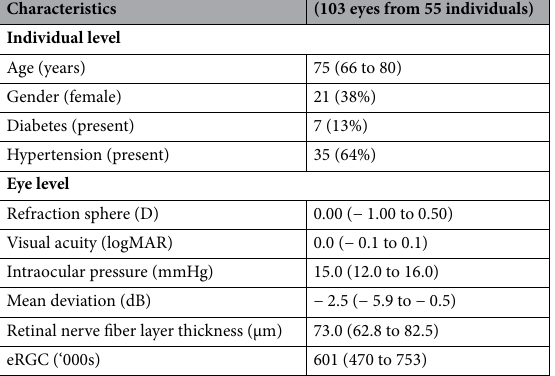
Table 1. Characteristics of the individuals and eyes with glaucoma in this study. Continuous statistics presented as median and interquartile range, categorical statistics as number and percentage. logMAR logarithm of the minimum angle of resolution, eRGC estimated retinal ganglion cell count.